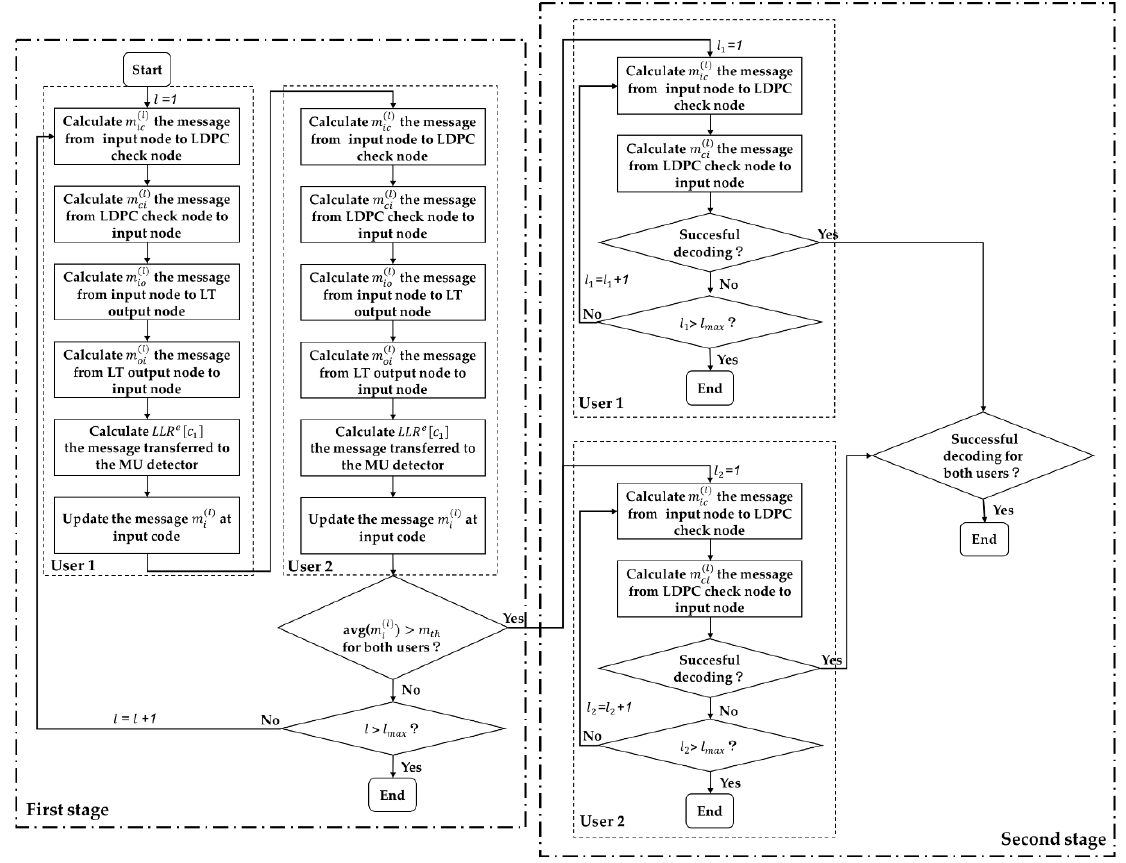
Figure 3. Flow chart of the decoding procedure.